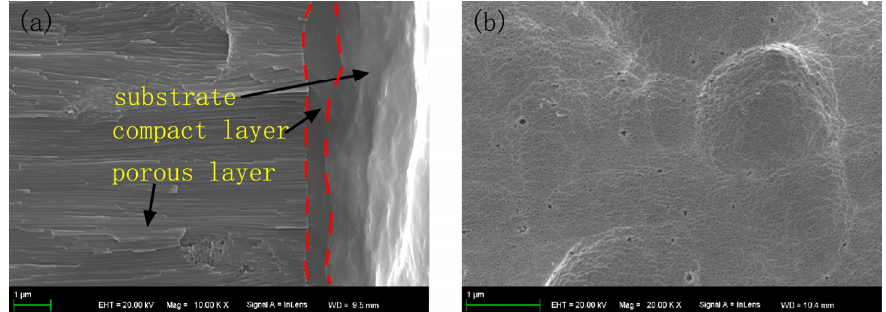
Figure 1. The ( a ) cross-section and ( b ) micro surface of the anodic coating. Figure 2 illustrates the micro surface structure and its porosity photograph of the anodic coating treated at different temperatures. It can be seen that with the increase in hydro-thermal temperature, the quantity and size of cracks on the surface increases. Besides, the porosity of the coatings increases with the increase in hydro-thermal temperature. The main reason is that of temperature; the amorphous alumina was transformed into a crystalline structure, and the bound water contained in the amorphous alumina was released. The water in the pore was gasified at high temperatures and the volume increased [31]. After the hydro-thermal treatment was completed, the water vapor in the pore was liquefied and the volume decreases. Because the volume of crystalline alumina is smaller than that of hydrated alumina [32], micro cracks were produced in the coating due to dehydration force.